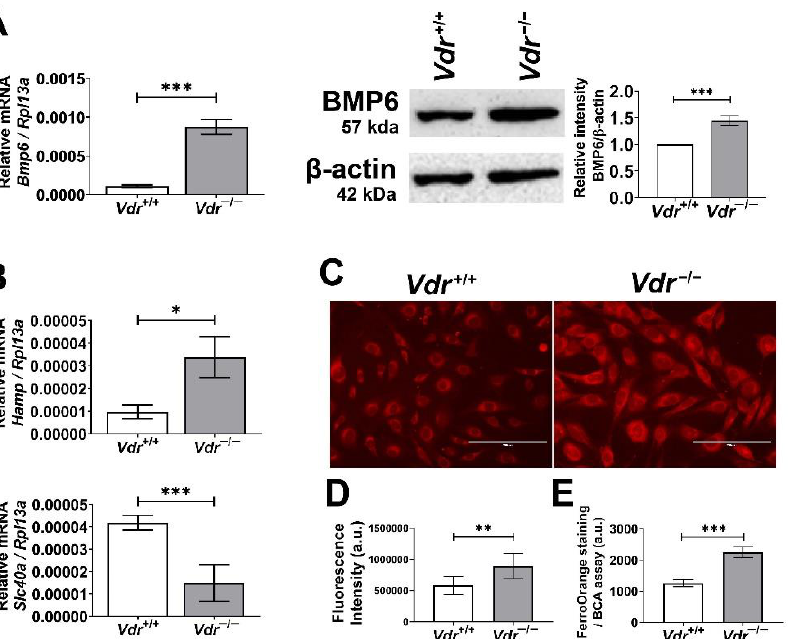
Figure 9. Alterations in expression of genes involved in iron homeostasis and intracellular iron levels